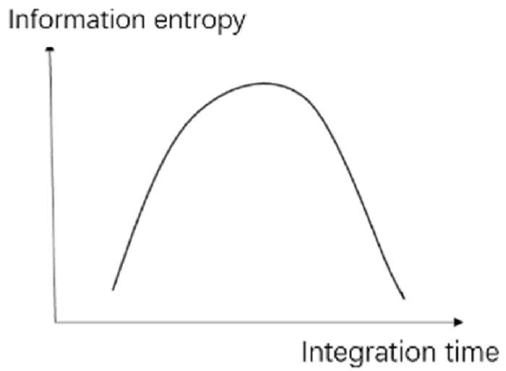
Figure 9. Relationship between information entropy and exposure time. (2)